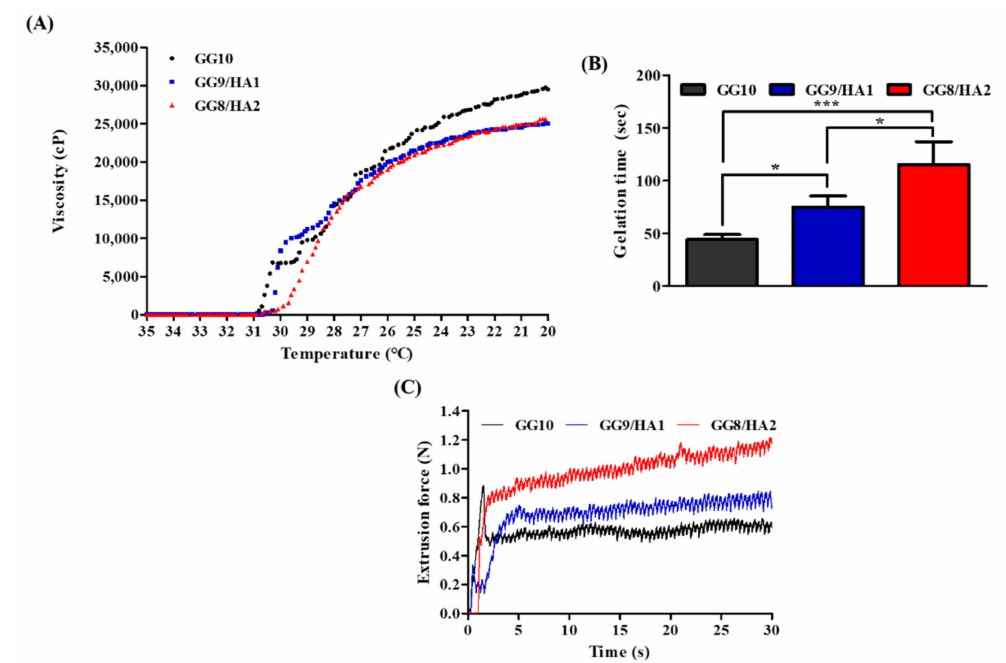
Figure 2. Characterization of gelation temperature, time, and injectability of the hydrogels. ( A ) Vis- cosity study evaluated at a temperature range of 35 ◦ C to 20 ◦ C; ( B ) analysis of gelation time at the gelation temperature; ( C ) characterization of injection force using a syringe capped with a 26G 1 needle, Texture Analyzer at a speed of 20 mm/min, and load cell of 20 N (values are mean ± SD ( n = 4), p < 0.05 (*), p < 0.001